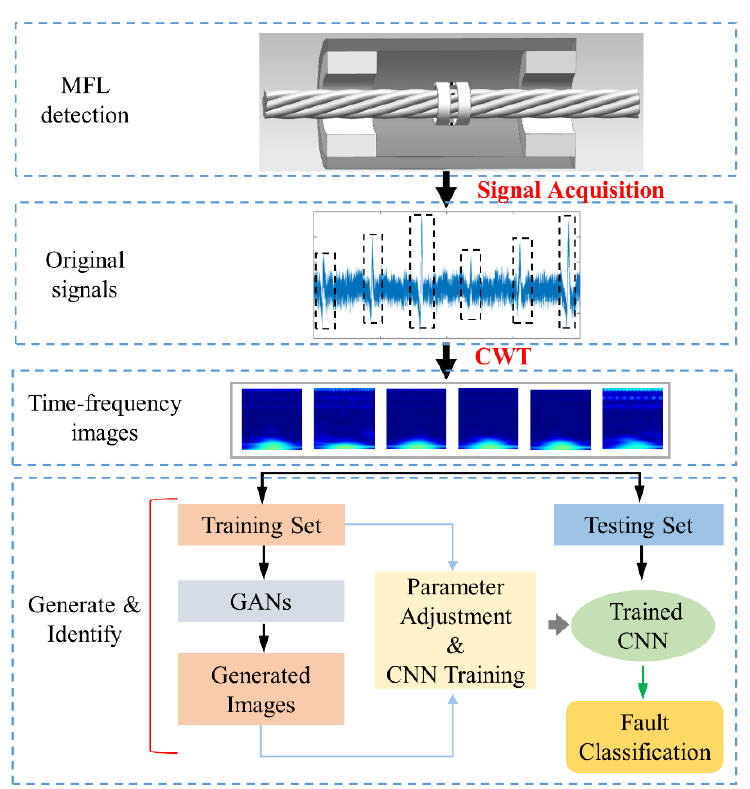
Figure 3. The framework of the proposed method.